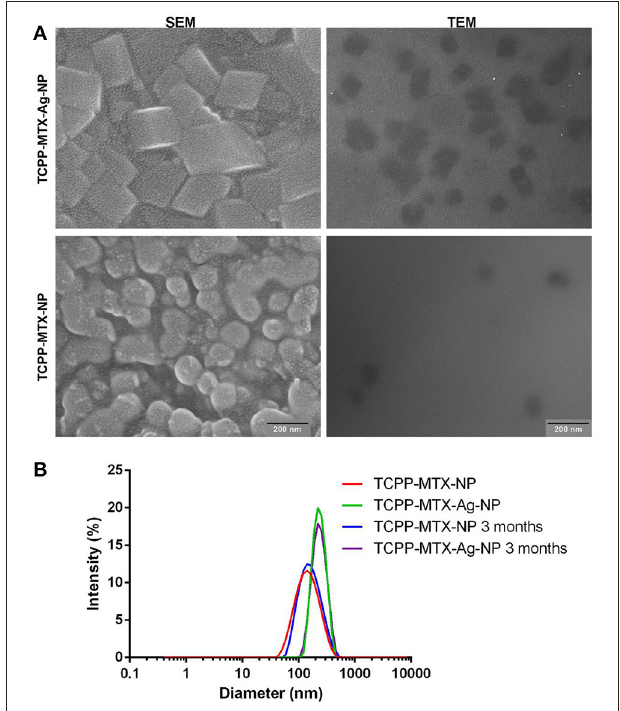
FIGURE 1 | The morphology and size of the supermolecular nano-carriers (the scale bar represents 200nm). (A) The SEM and TEM images of the nanoparticles; (B) The size distribution of the nanoparticles in saline before and after storage at 4 ◦ C by the DLS